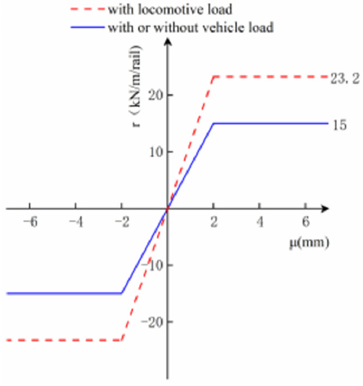
Figure 5. Type III sleeper resistance curve.